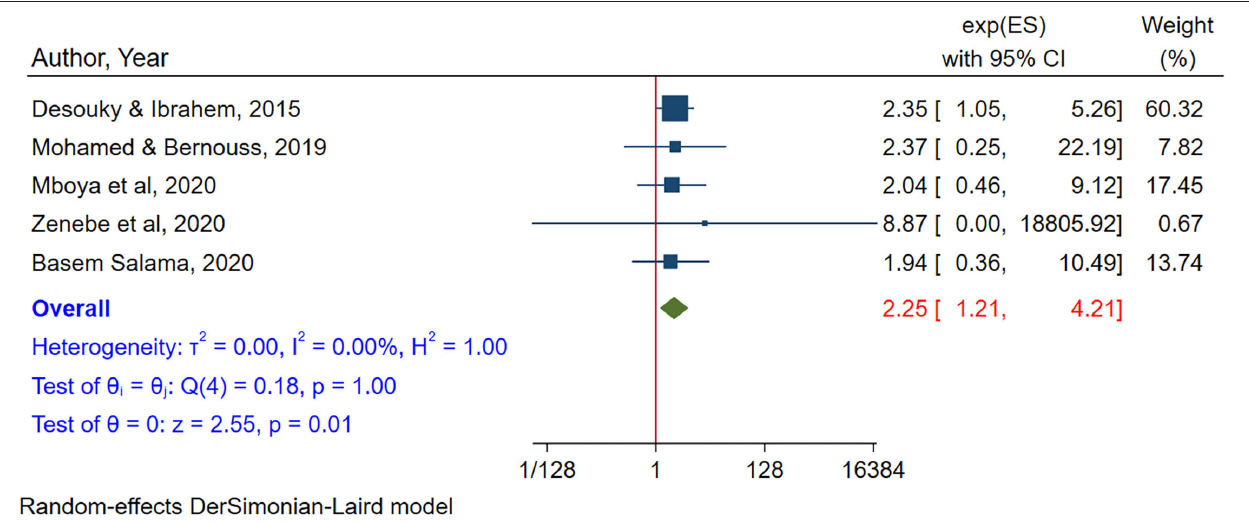
FIGURE 6 | The pooled association between duration of internet use and internet addiction.